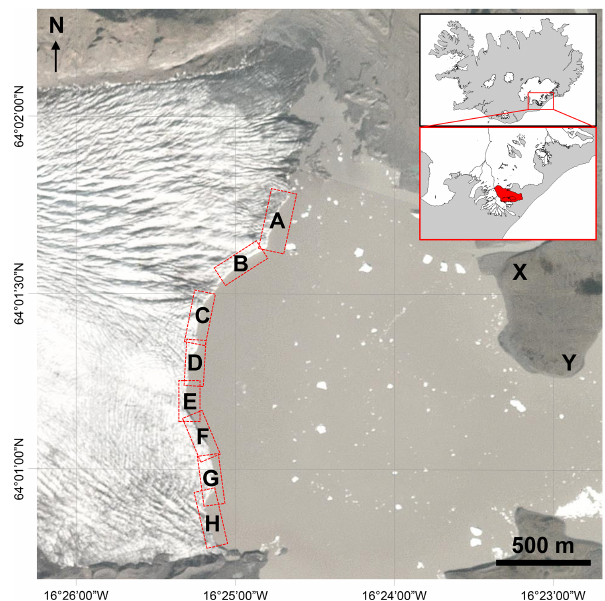
Figure 1. Fjallsjökull (flowing left-to-right), terminating in Fjallsár- lón, captured by Planet Imagery on 10 September 2021. A–H denote the eight point cloud sub-sections generated by both the Raspberry Pi and UAV. X–Y denote the start and end of land-based data col- lection at approximately 25m intervals along the shoreline, used to generate sub-section B from a distance.